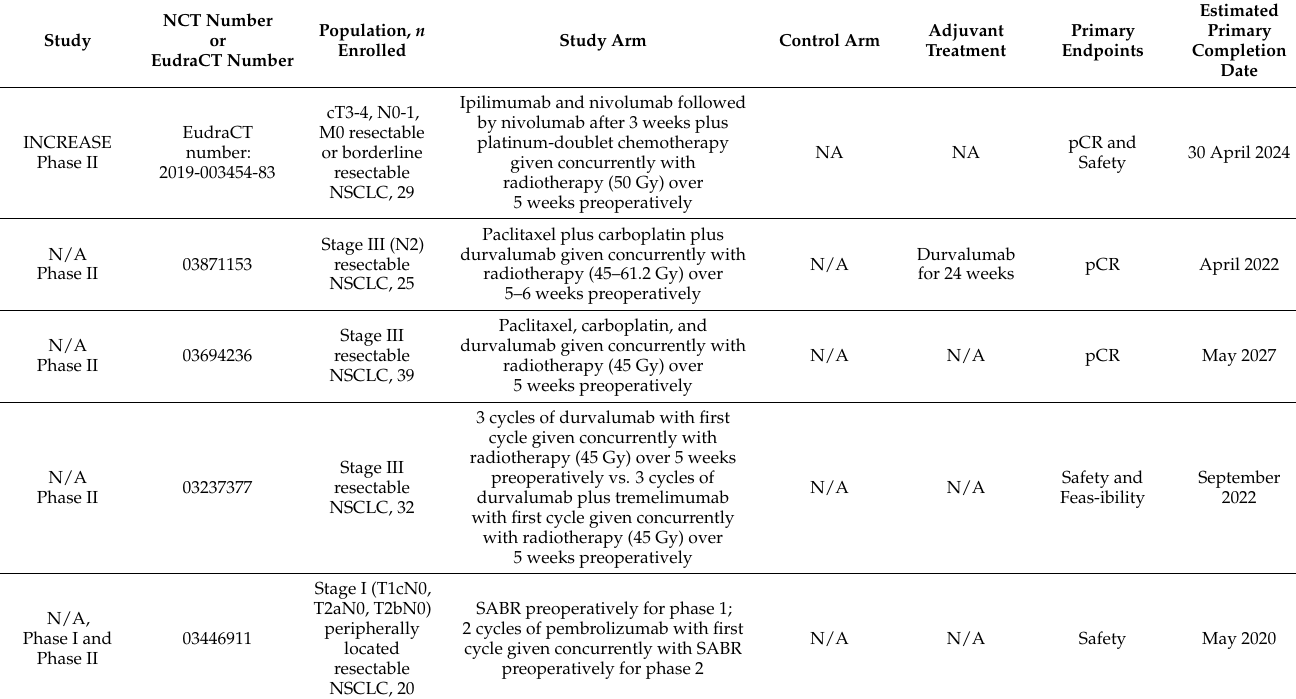
Table 4. Summary of Upcoming Neoadjuvant Radiotherapy with Neoadjuvant Immunotherapy or Chemotherapy Trials.